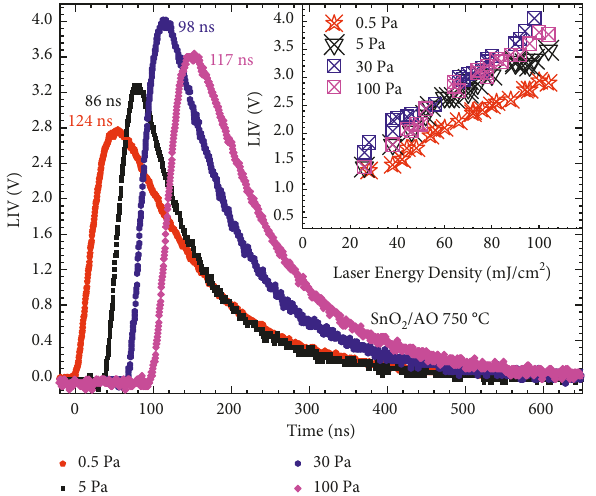
Figure 2: XRD curves for the SnO 2 (200) diffraction peak of the film grown at 750 pressure at 0.5Pa, 5Pa, 30Pa, and 100Pa.